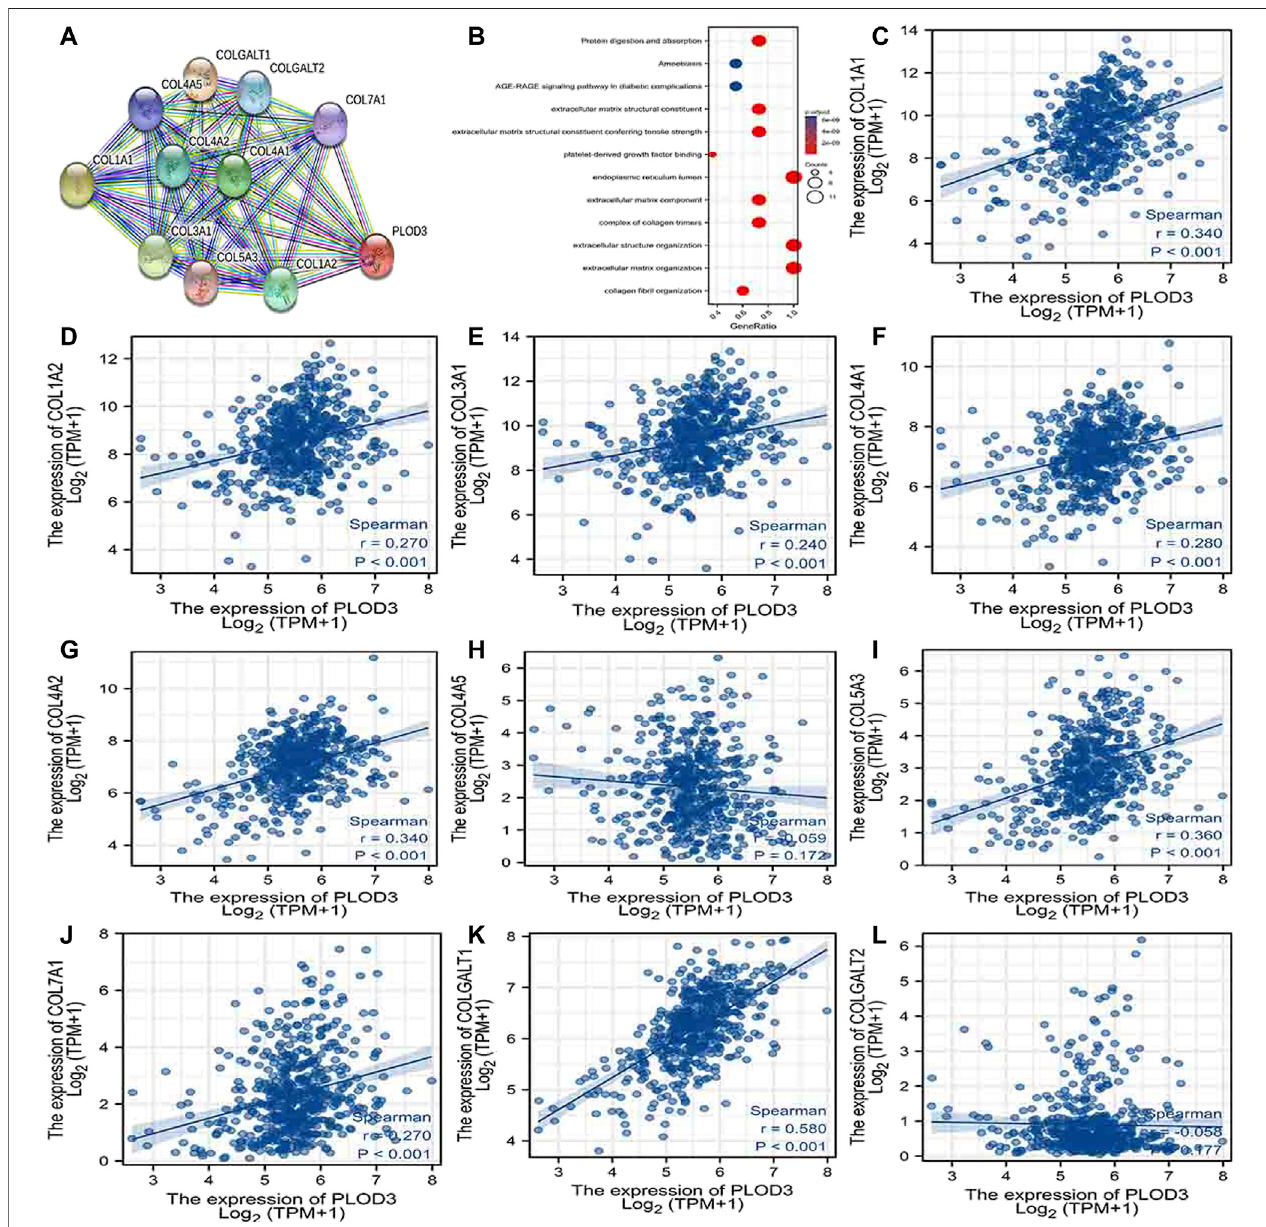
FIGURE 8 | PLOD3 PPI network and biological function annotation. (A) Network of PLOD3 and its co-expressed genes. (B) Functional enrichment analysis of 10 network genes. PLOD3 was associated with collagen fi bril organization, extracellular matrix organization, and extracellular structure organization. These genes were involvedinproteindigestionandabsorption,amoebiasis,andAGE-RAGEsignalingindiabetes. (C – L) CorrelationsbetweentheexpressionofPLOD3andco-expressed genes in lung adenocarcinoma. COL1A1, collagen alpha-1(I) chain; COL1A2, collagen alpha-2(I) chain; COL3A1, collagen alpha-1(III) chain; COL4A1, collagen alpha-1(IV) chain; COL4A2, collagen alpha-2(IV) chain; COL4A5, collagen alpha-5(IV) chain; COL5A3, collagen alpha-3(V) chain; COL7A1, collagen alpha-1(VII) chain; COLGALT1, procollagen galactosyltransferase 1; COLGALT2, procollagen galactosyltransferase